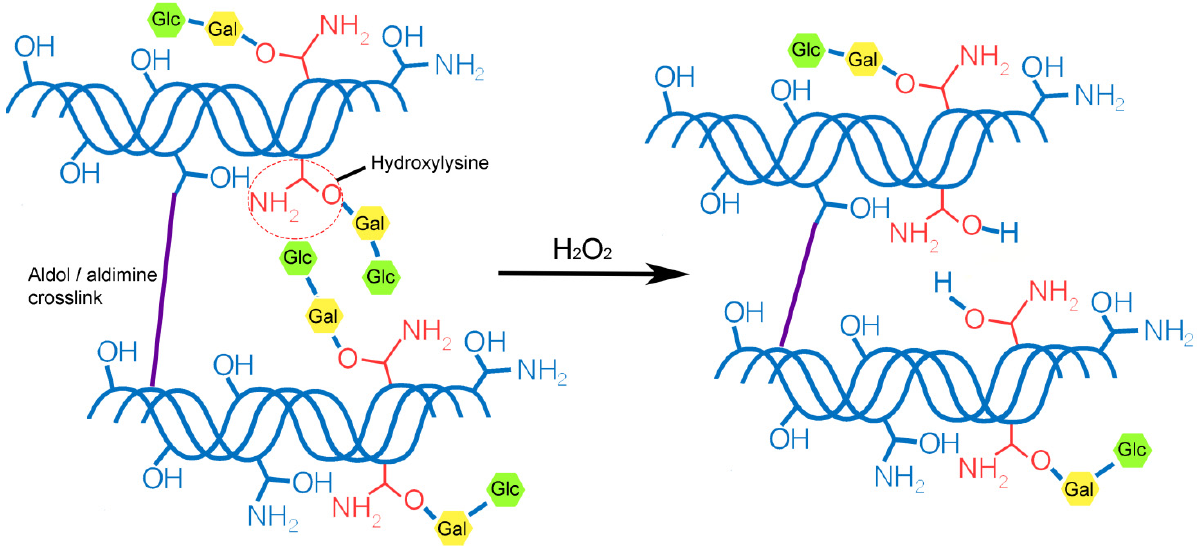
Figure 4. Schematic diagram of collagen fibril structure modification after hydroxide peroxide treatment. (Gal—galactose, Glc—glucose).